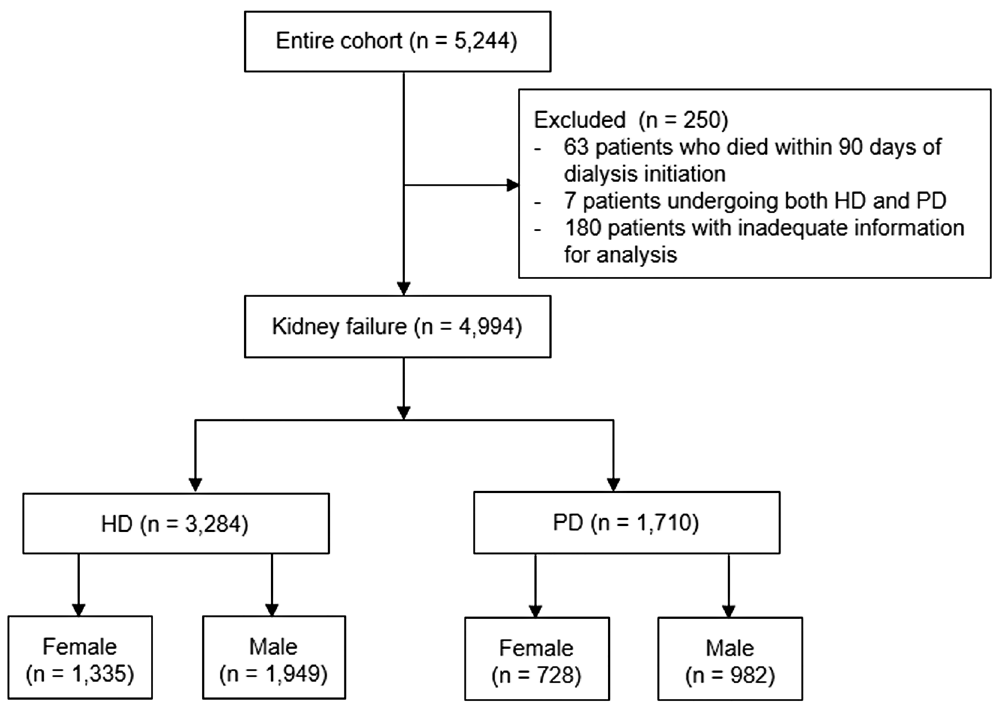
Figure 1. Flow chart of participant inclusion. Among a total of 5244 incident and prevalent patients receiving dialysis, 63 patients who died within 90 days of dialysis initiation, 7 patients undergoing both hemodialysis (HD) and peritoneal dialysis (PD), and 180 patients with inadequate information for analysis were excluded. Thus, a total of 3284 patients on HD and 1710 patients on PD were included in this